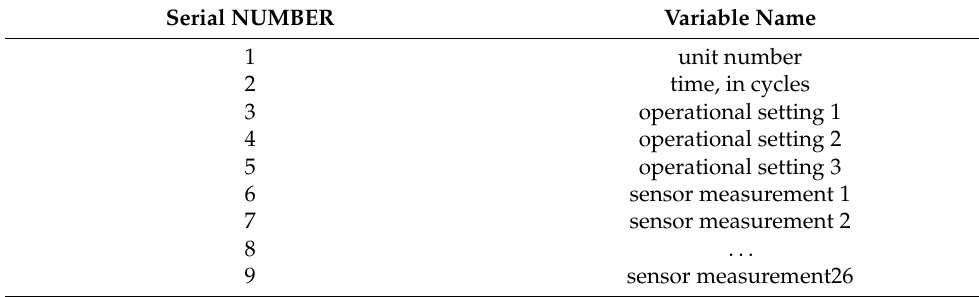
Table 1. Column contents of data set file.